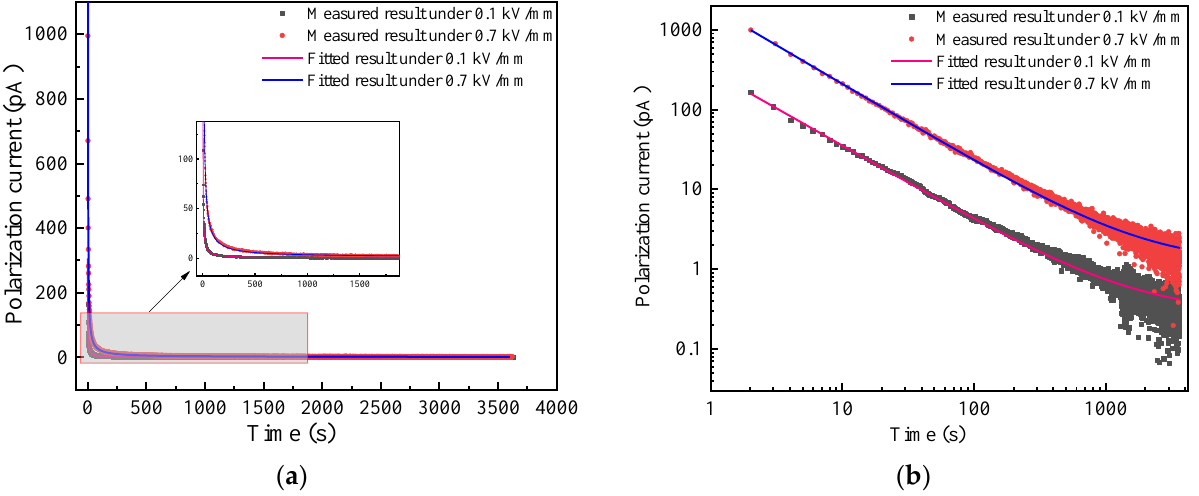
Figure 4. Current TDS of BN powder at 25 °C. ( a ) Linear coordinate; ( b ) double logarithmic coordinate. It can be seen from Figure 4b that the current TDS changes as a straight line with time at the beginning and gradually tends to the steady state in the double logarithmic coordinate. The relationship between the current and time is consistent with the Curie von Schweidler relation also called “universal law” as shown in Equation (1), which is recognized by many scholars [15] and is used to fit the experimental results in Figure